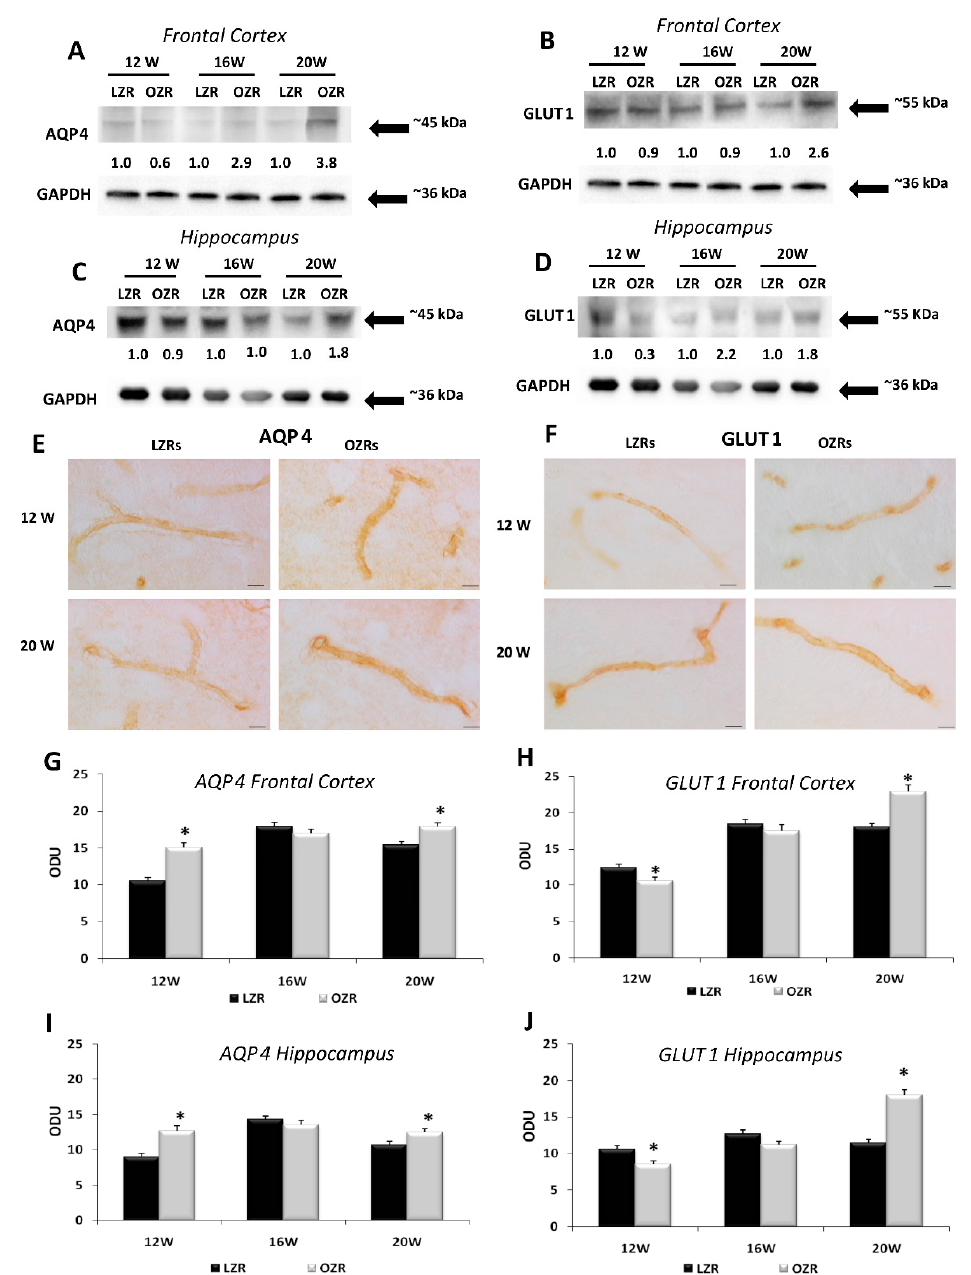
Figure 5. BBB Markers. Immunochemical analysis of the frontal cortex ( A , B ) and hippocampus ( C , D ) processed for aquaporin-4 (AQP4) ( A , C ) and glucose transporter-1 (GLUT1) ( B , D ). To investigate more than AQP4 and GLUT1 proteins on the same blot, both membranes of the frontal cortex and hippocampus were stripped and incubated with anti-GAPDH antibody (loading control). Control images are re-used for illustrative purposes. The densitometric analysis of bands is expressed as the ratio between the optical density of protein and reference protein (GADPH) where the value for LZRs